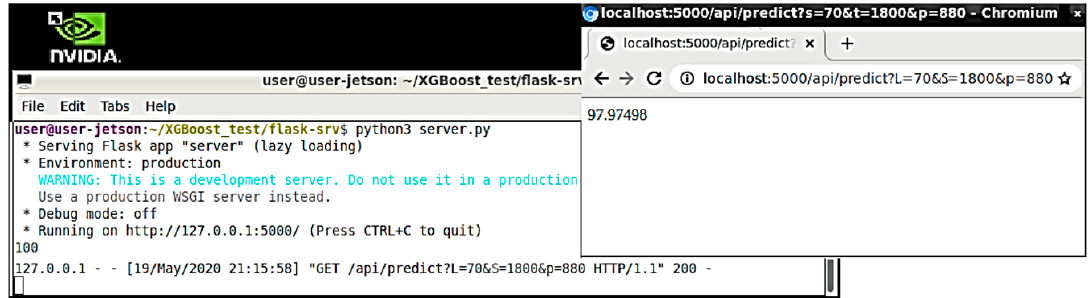
Figure 19. LXDE (light-weight X11) directives, intranet ANN invoking, and Pe prediction publishing using a normal browser.